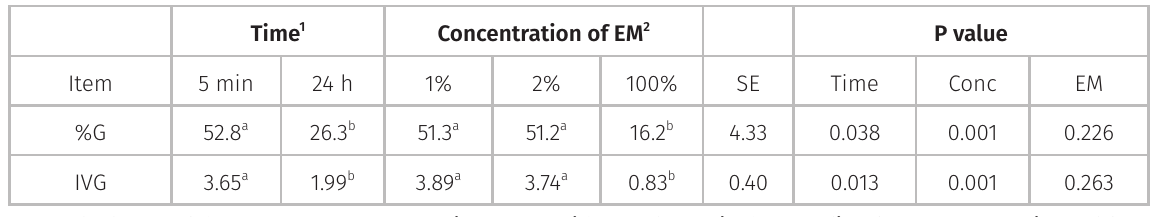
Table IV. Germination percentage (%G) and germination speed index (IVG) of palisade grass seeds treated with EM, for two immersion times and at three concentrations.